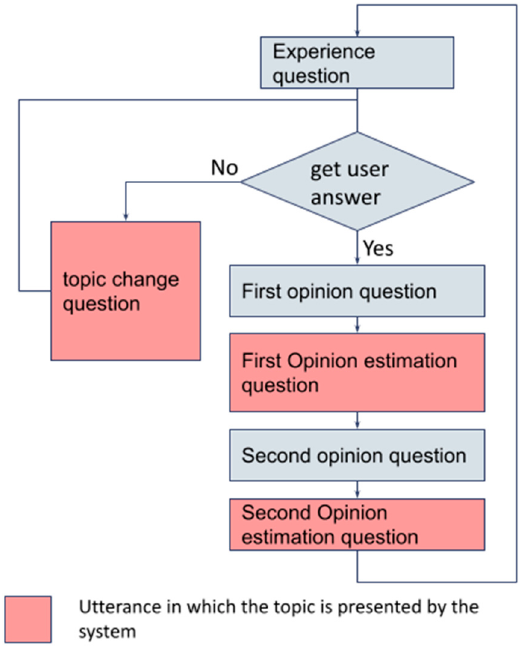
Figure 3. Dialogue Figure 3. Dialogue flow.